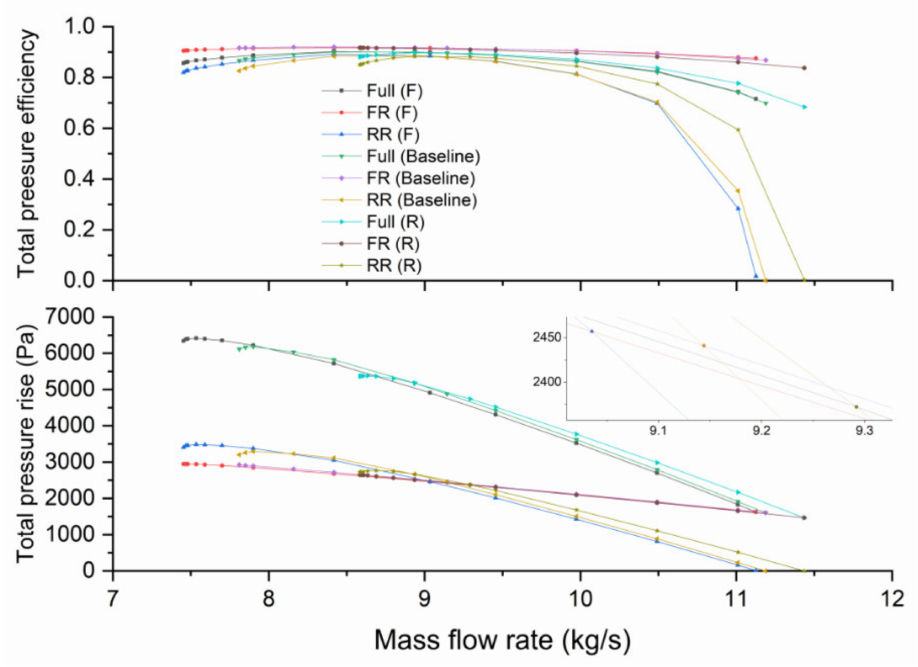
Figure 13. Effect of load control on the performance and efficiency of three sets of